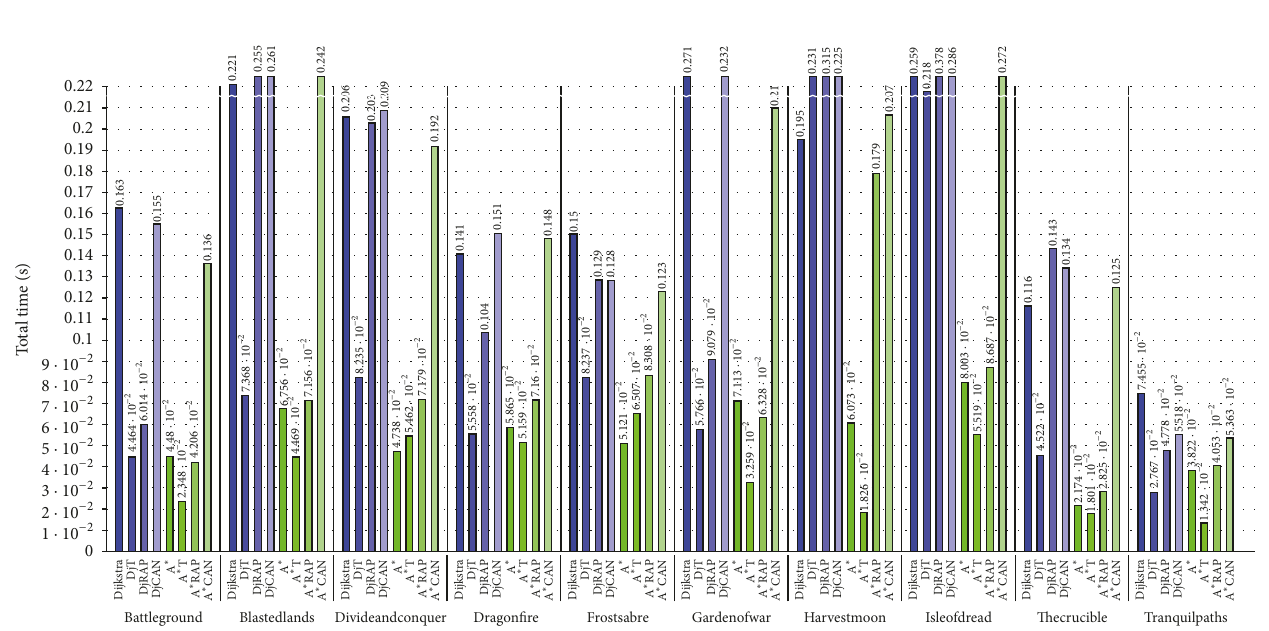
Figure 14: Time performance for 10 maps of Warcraft III